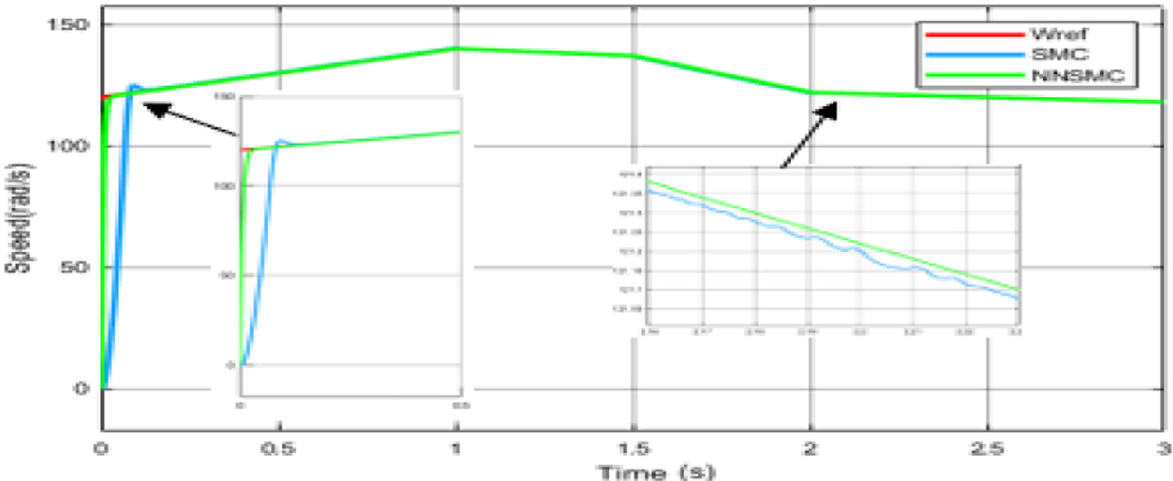
Fig. 17 Waveform of induction motor mechanical